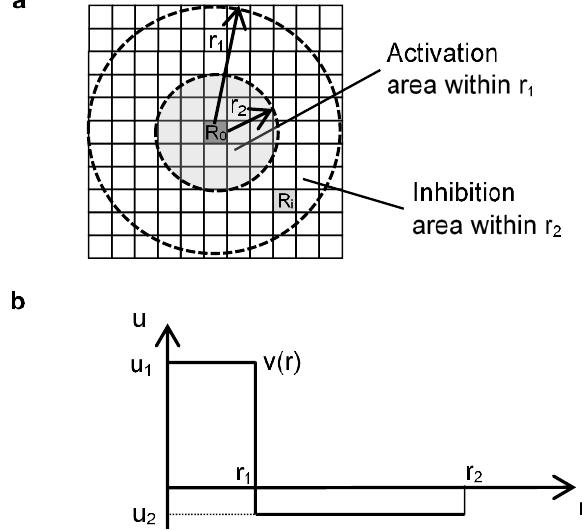
Figure 3. Outline of Young’s model. ( a ) The activation area has a radius r 1 and the inhibition area has an outer radius r 2 ; ( b ) Function v(r) is a continuous step function representing the activation area and inhibition area.